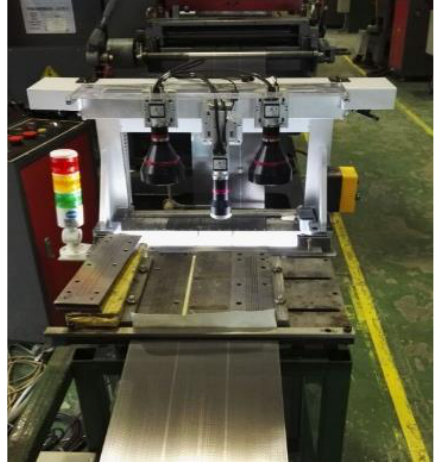
Figure 1. The diagram of hardware system.